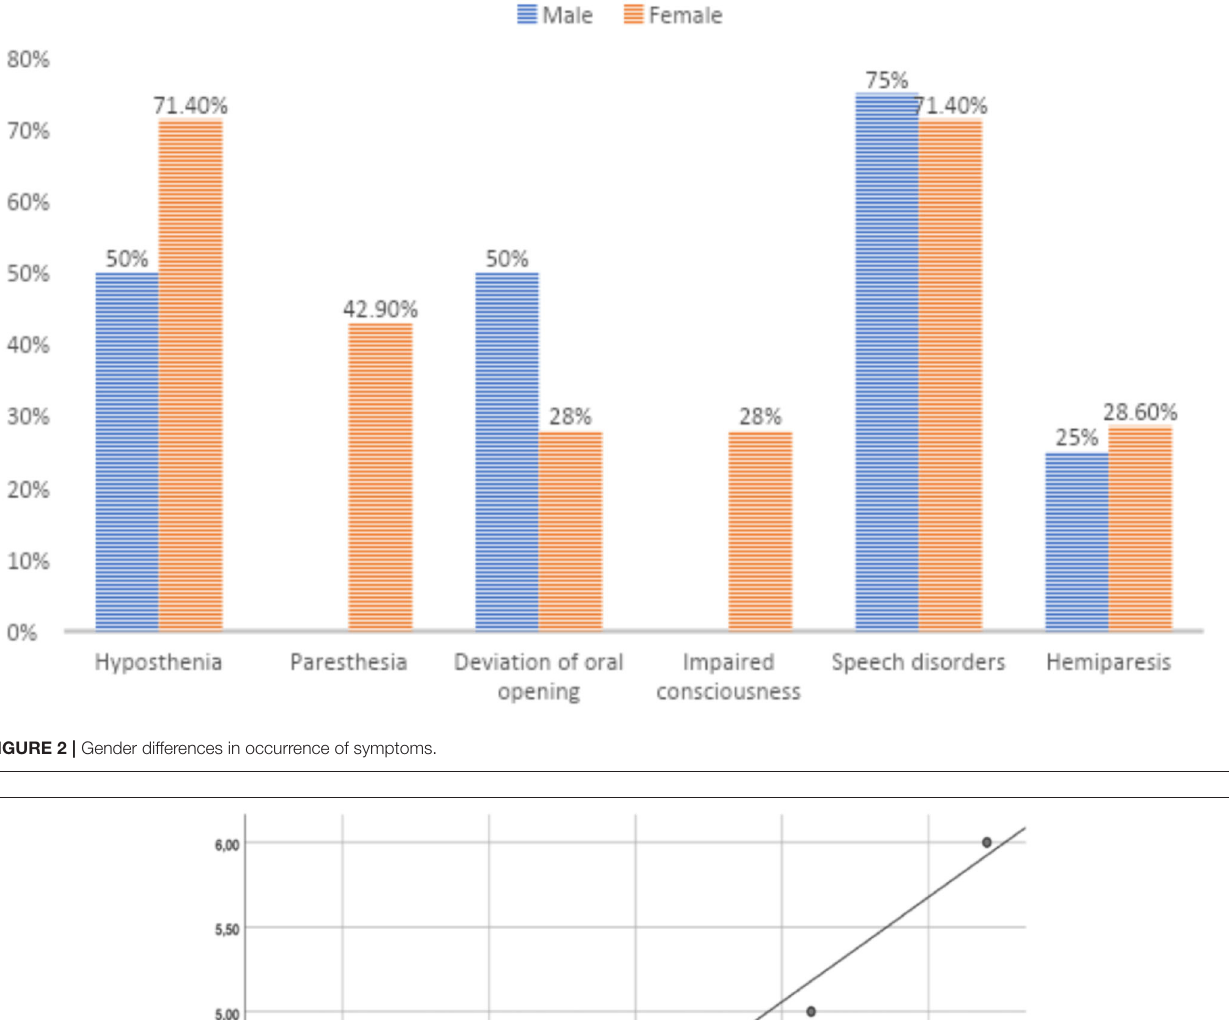
FIGURE 2 | Gender differences in occurrence of symptoms.